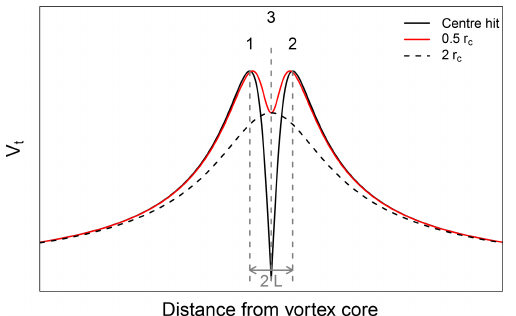
Figure 12. Qualitative example of an ideal flight path (vortex 1) and a passing one with a little offset (vortex 2) of the UAS. For the field measurement, the distances d 1 and d 2 are calculated from the UAS GPS position and the location (offset) of the vortex in relative coordinates, with WEC at (0 , 0) indicated with a black dot. The vor- tex position can be derived from the extent of the tangential velocity V t measured by the UAS and the peak-to-peak distance, explained p (cid:49)x 2 + (cid:49)y 2 with in the previous sections. In this example, d 1 , 2 = (cid:49)y 1 = 0 for d 1 and (cid:49)y 2 = const . (cid:54)= 0 for d 2